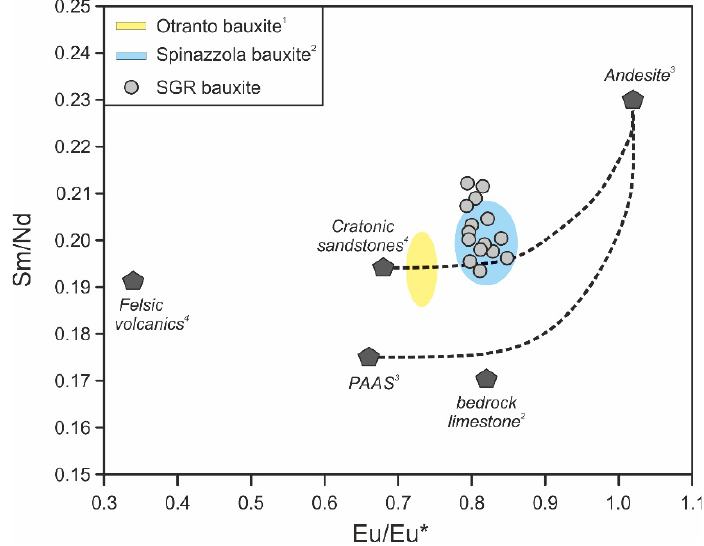
Figure 10. Eu/Eu* versus Sm/Nd diagram showing mixing lines between average standard lithologies. Grey circles are samples from the SGR bauxite; yellow and blue ovals are the compositional fields of the Otranto and Spinazzola bauxites, respectively. 1 : data from [14], 2 : data from [13], 3 : data from [35], 4 : data from [51].